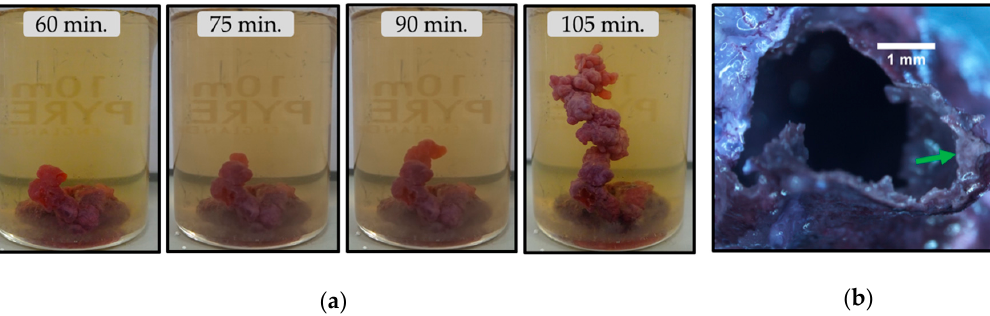
Figure 1. The growth process of calcium carbonate garden. The diameter of the vial is 1.45 cm .